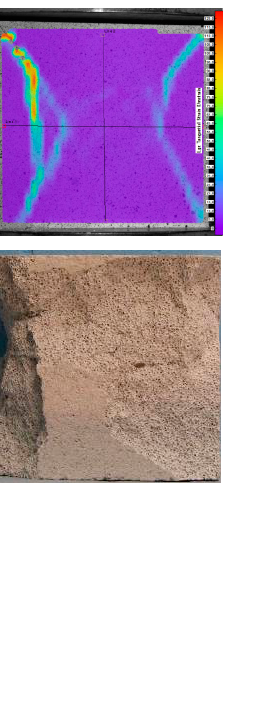
Figure 2. Testing compressive strength of AAC specimens [27]: ( a ) tests on cores using a strength testing machine with an operating range of 100 kN, and ( b ) tests on cuboid specimens using a strength testing machine with an operating range of 3000 kN.